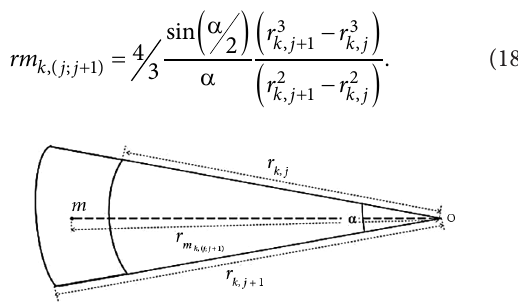
Figure 7. Finding the center of mass of the ring sector 5. Upon receiving the distance value